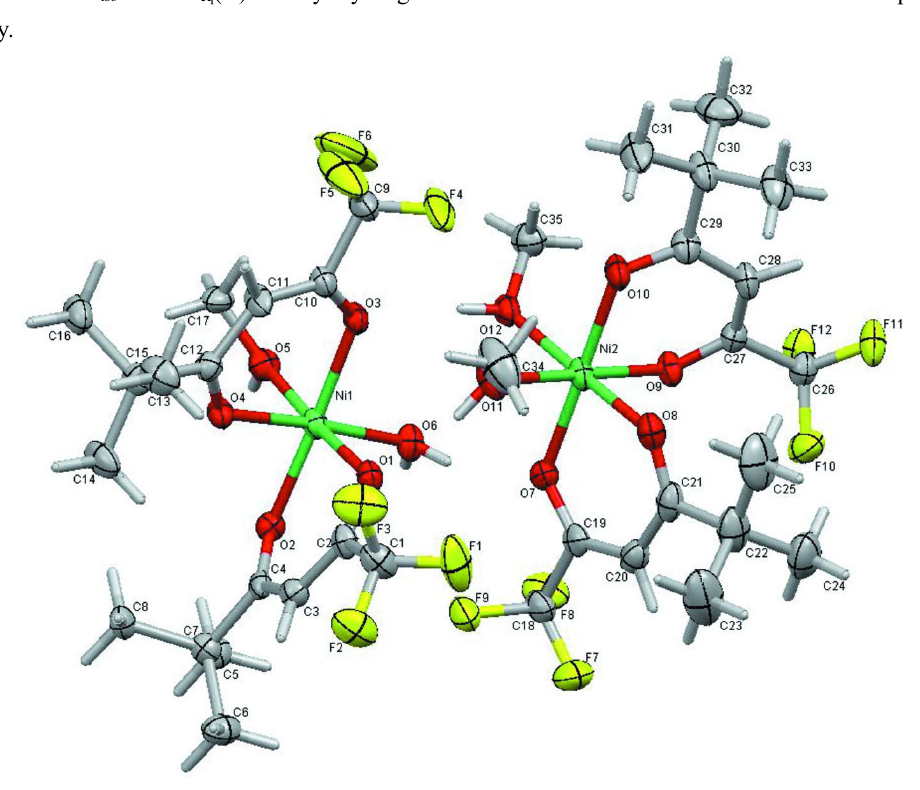
Thermal ellipsoid respresentation of the two crystallograpically independent molecules. The probability level for the anisotropic displacement parameters is at 50%. Minor moieties of disordered sections are omitted for